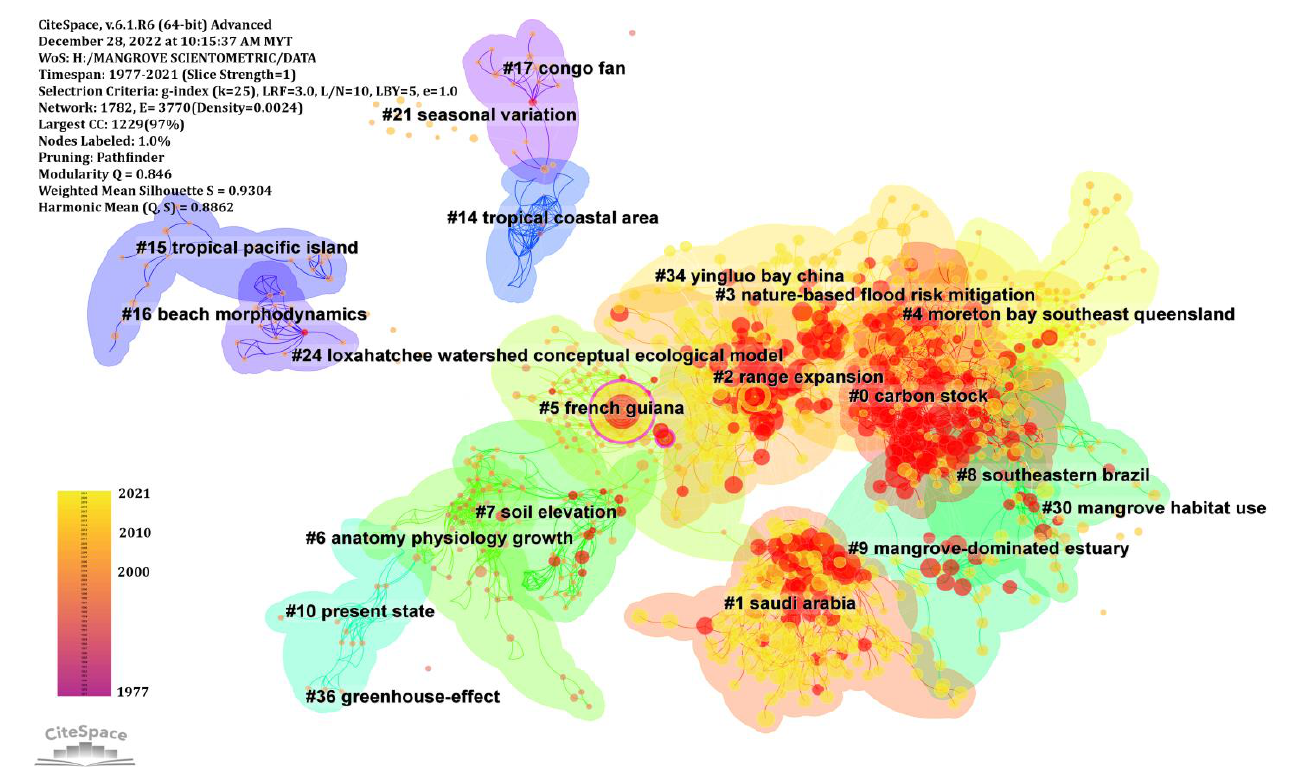
Figure 6. The reference co-citation network of publications on mangroves and climate change from 1977 to 2021 was analyzed. The size of the nodes in the network reflects the frequency of citation, while the colors of the nodes, ranging from magenta (1977) to yellow (2021), indicate the progression of research over time. The colored connections represent co-citation relationships. The network was further divided into 42 clusters through network clustering analysis . Table 3. Top-ranked clusters and labels produced by LSI and LLR on mangrove forest-related stud- ies.